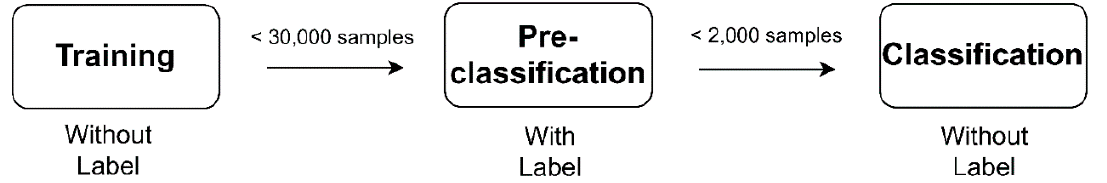
Figure 4. SNN Figure 4. SNN workflow.